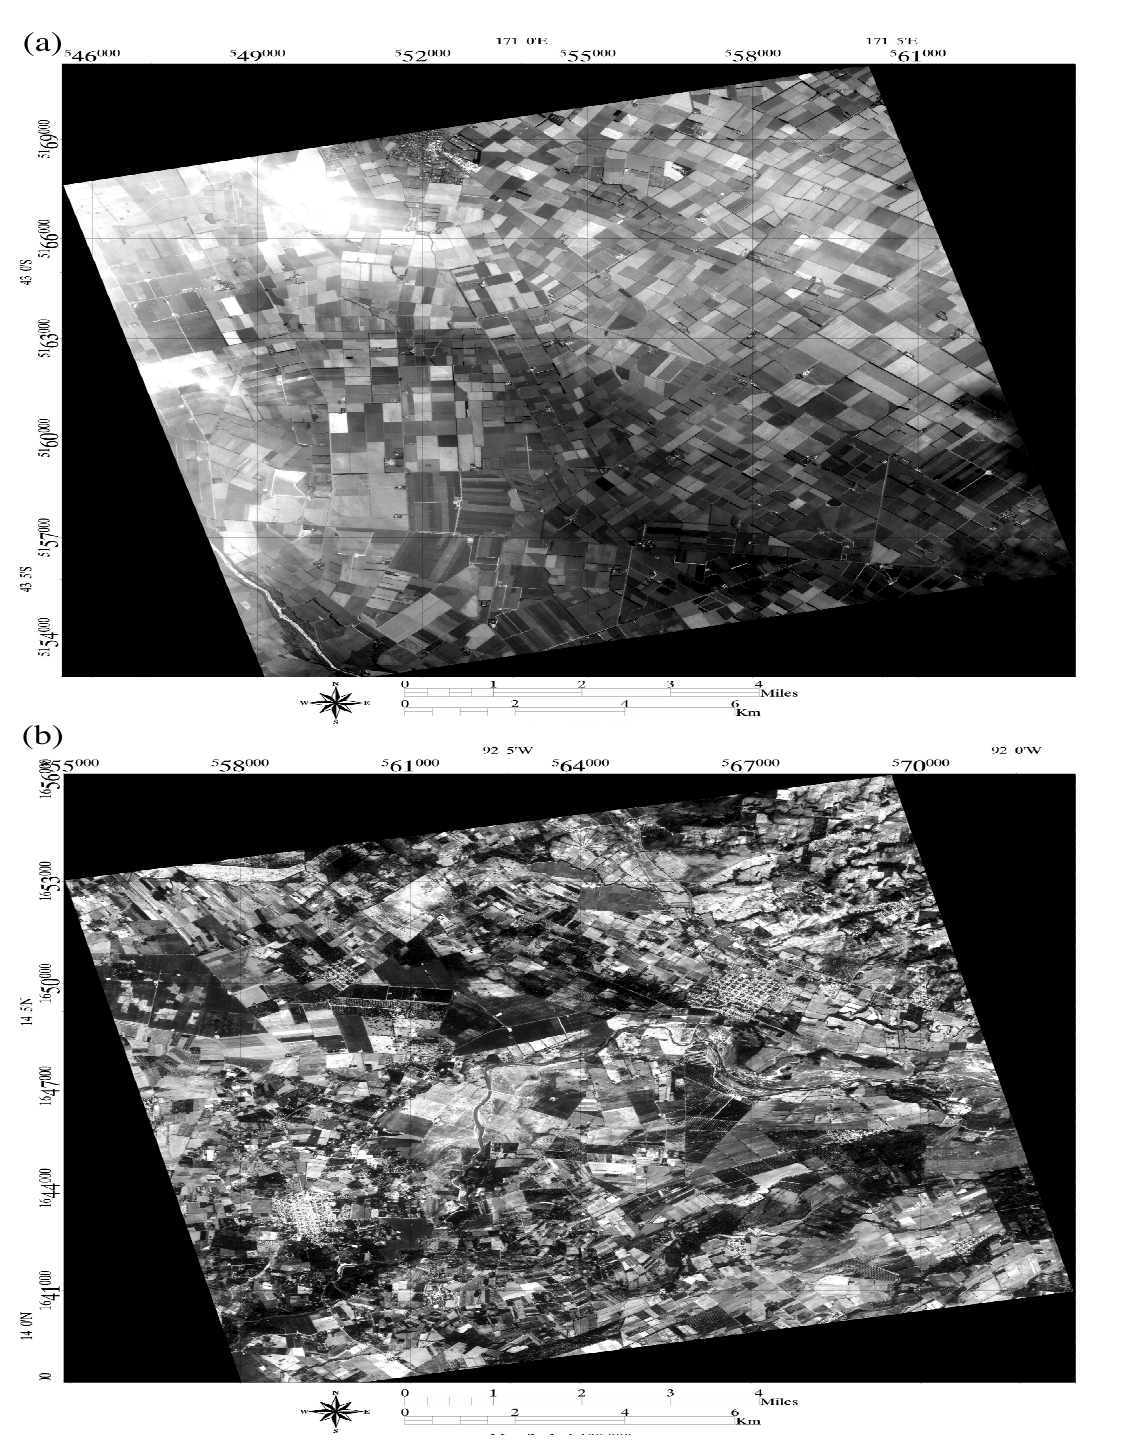
Figure 1. Study area of reference images: ( a ) set 1; ( b ) set